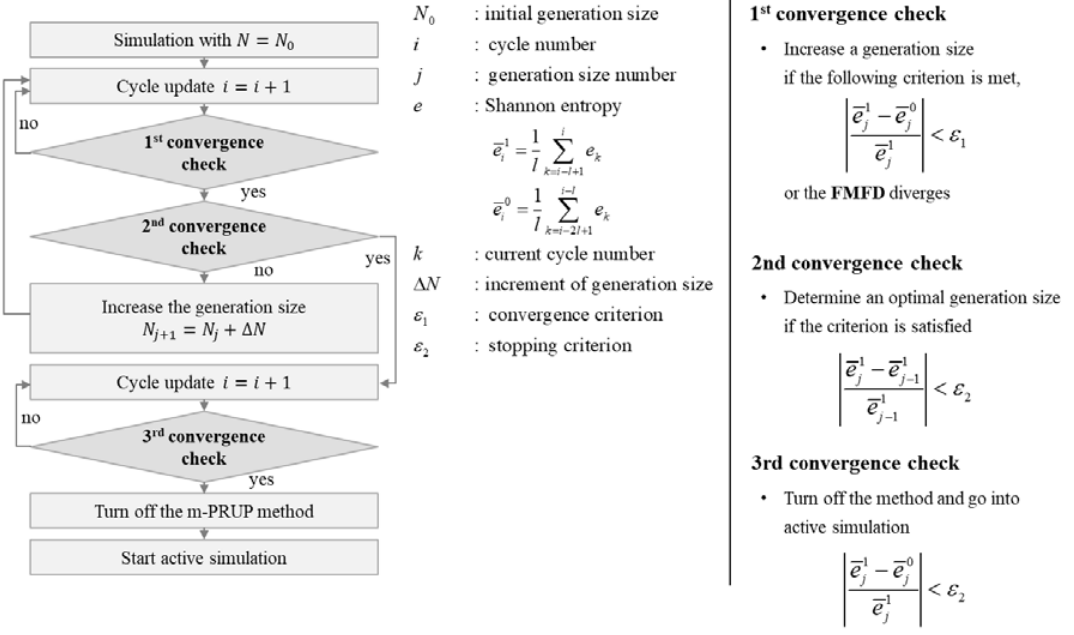
Figure 3. Algorithm of the m-PRUP